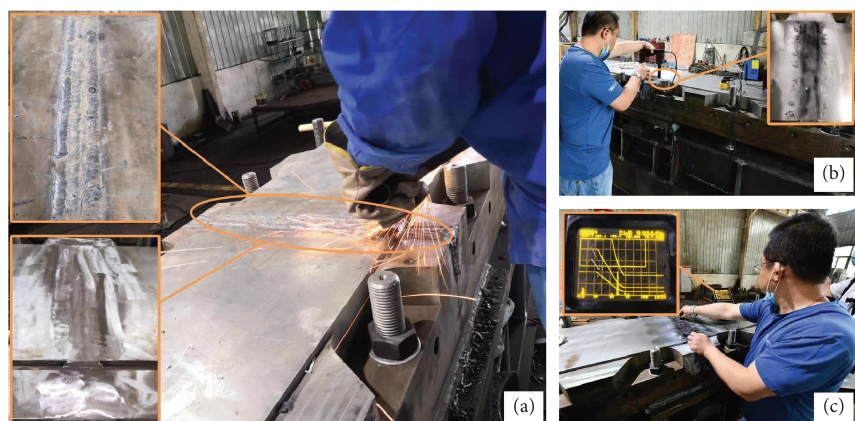
Figure 8: Weld inspection of the antenna’s azimuth track. (a) Grinding of the track. (b) Magnetic particle testing of the weld. (c) Ultrasonic testing of the